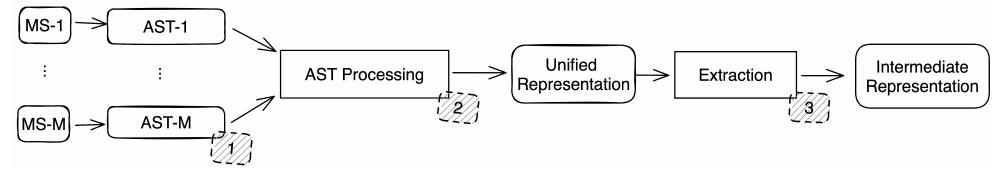
Figure 3. Architecture reconstruction designed